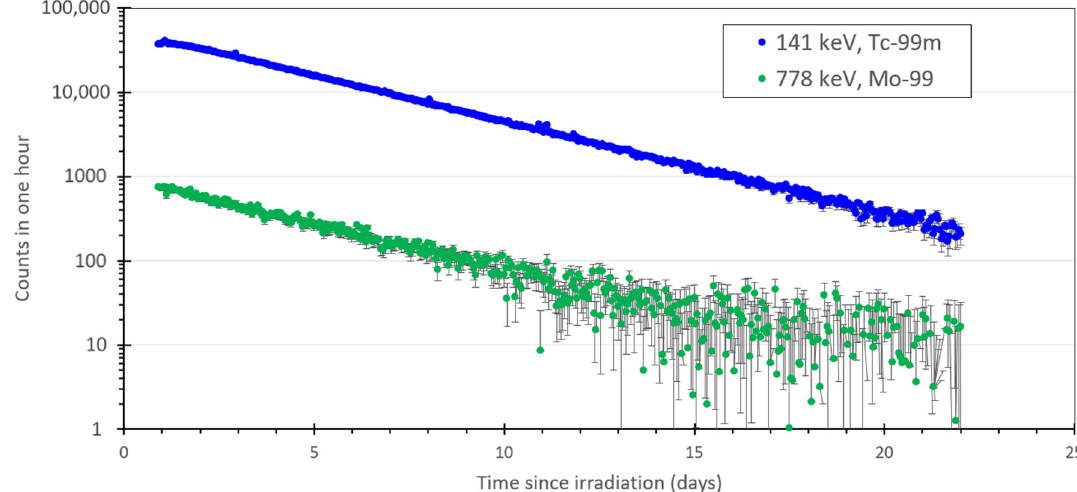
Figure 4. Total counts of 99 Mo/ 99m Tc following decay of 101 Mo/ 101 Tc from Figure 5 after an 18-h intermediate decay period. The 778 keV line is shown for 99 Mo (green) and the 141 keV line for 99m Tc (blue). Associated error bars are shown in black.